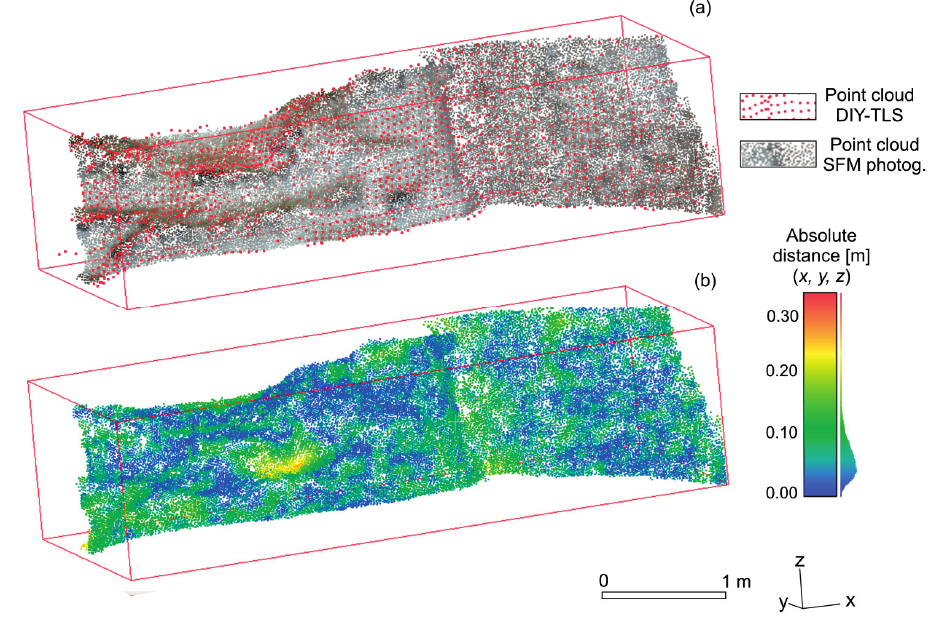
Figure 4. ( a ) View of the SFM photogrammetry and DIY-TLS point clouds on a portion of the study area. ( b ) Absolute distance between the two point cloud datasets, considering x , y , z spatial